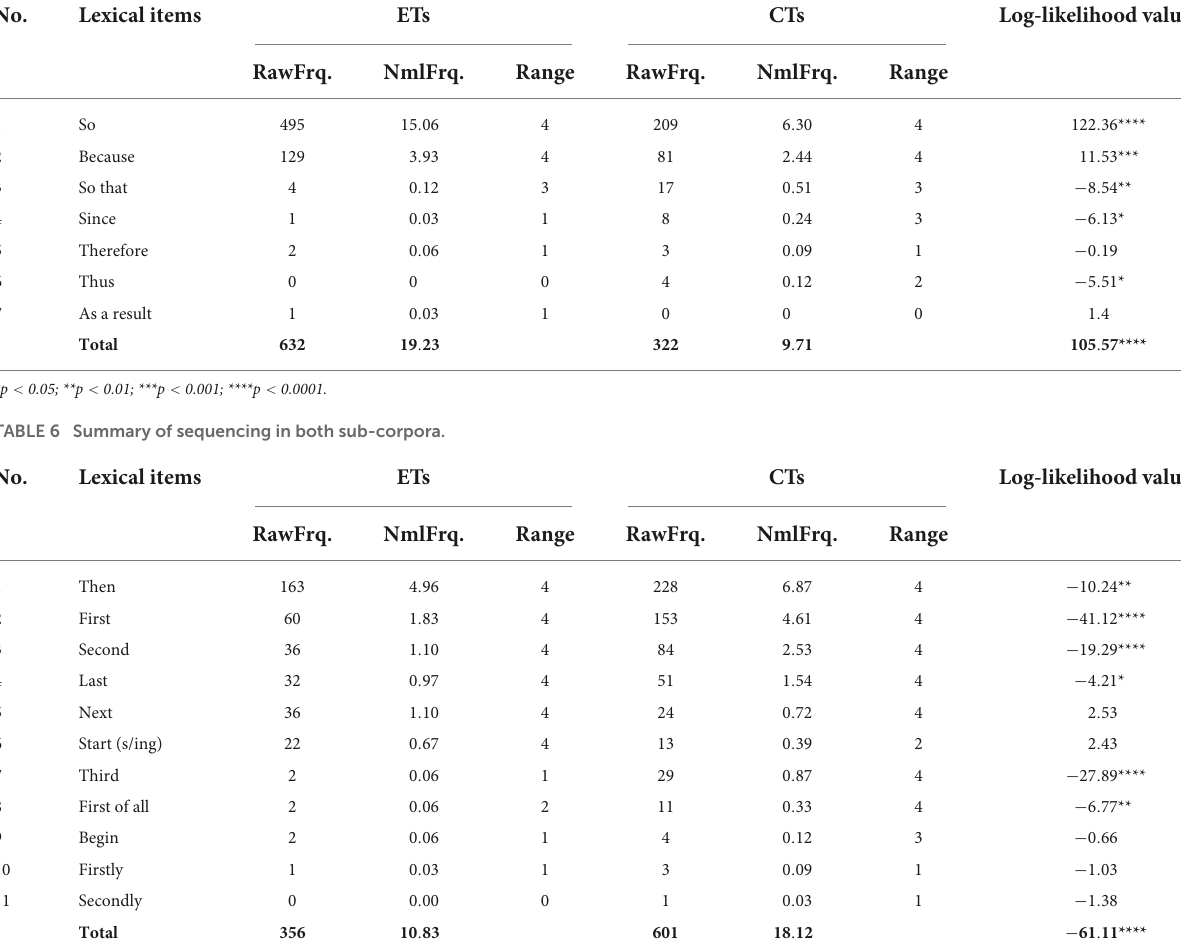
TABLE 5 Summary of consequential transitions in both sub-corpora.